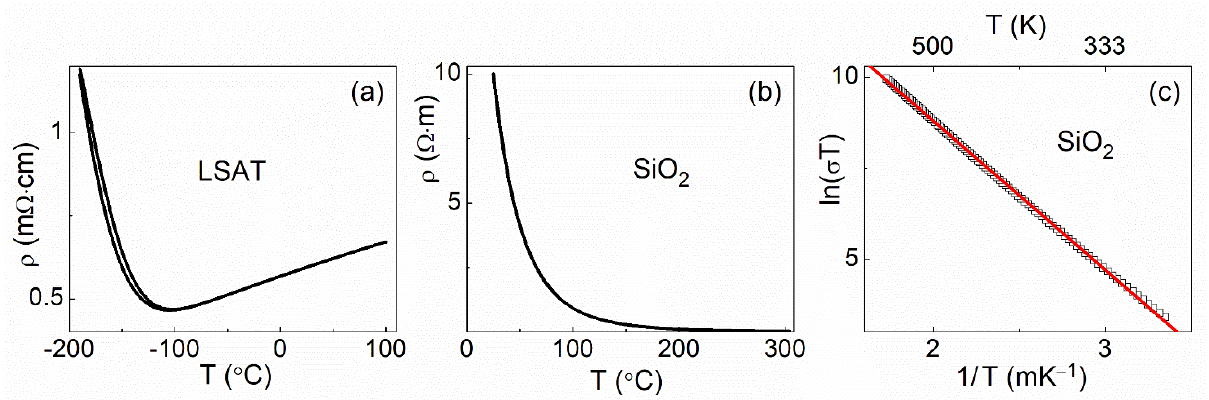
Figure 2. Resistivity temperature dependence at cooling–heating loop for NNO films on ( a ) LSAT and ( b ) SiO 2 substrates. ( c ) Adiabatic polaron hopping fit for the latter dependence.